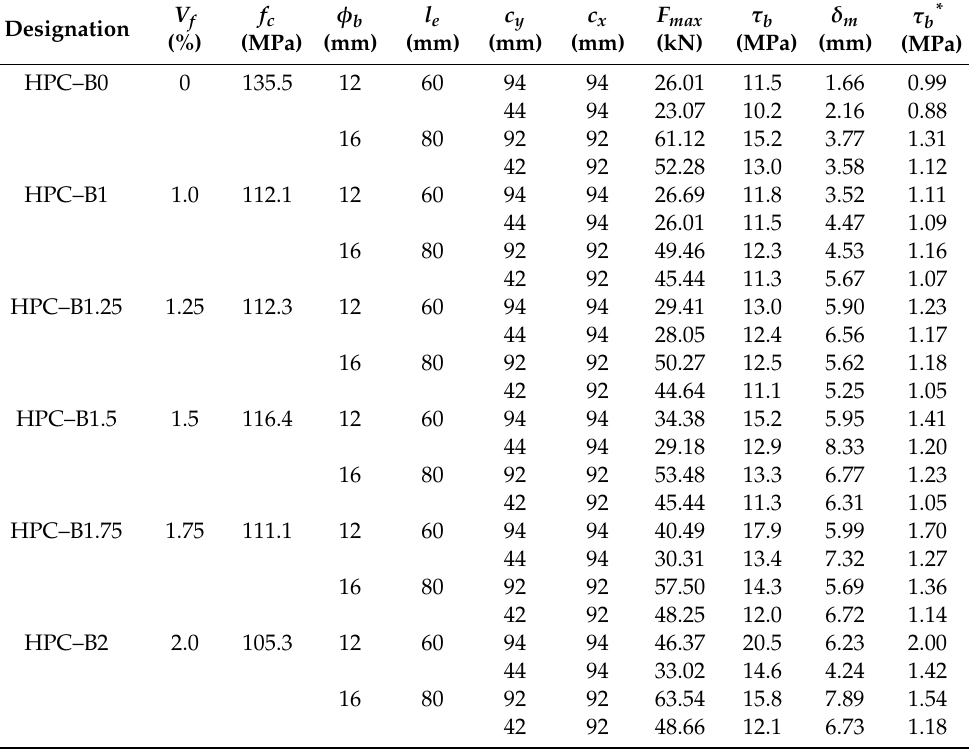
Table 5. Summary of pull-out test